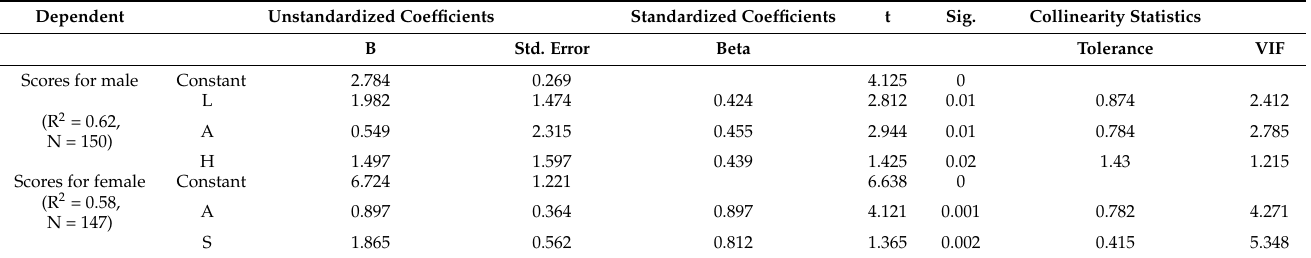
Table 9. The linear regression analysis of photos’ physical properties for different gender groups. Dependent Unstandardized Coefficients Standardized Coefficients t Sig. Collinearity